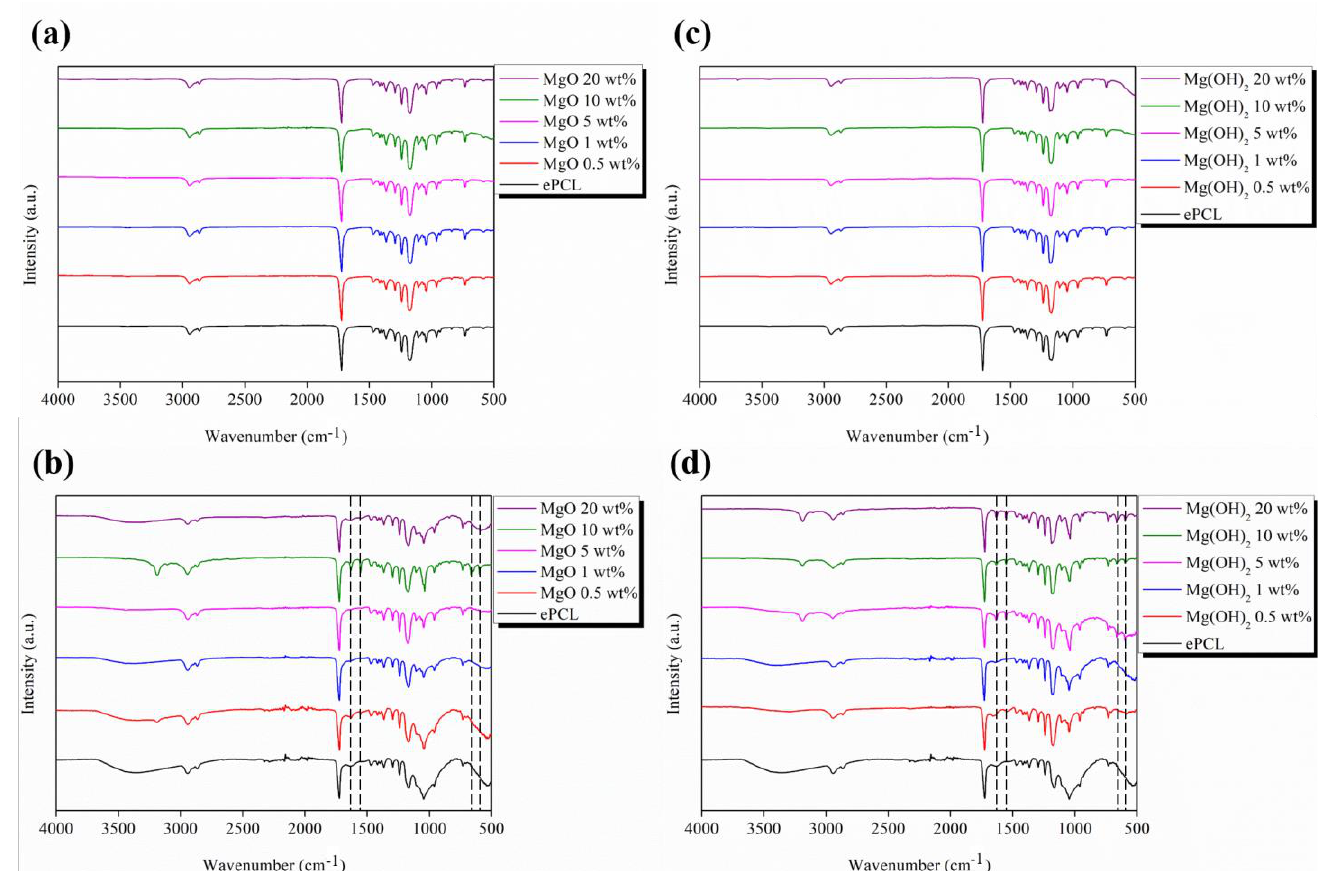
Figure 13. IR spectra of ( a ) ePCL + MgO at T0, ( b ) ePCL + MgO at T28 and ( c ) ePCL +Mg(OH) 2 at T0. ( d ) ePCL +Mg(OH) 2 at T28.